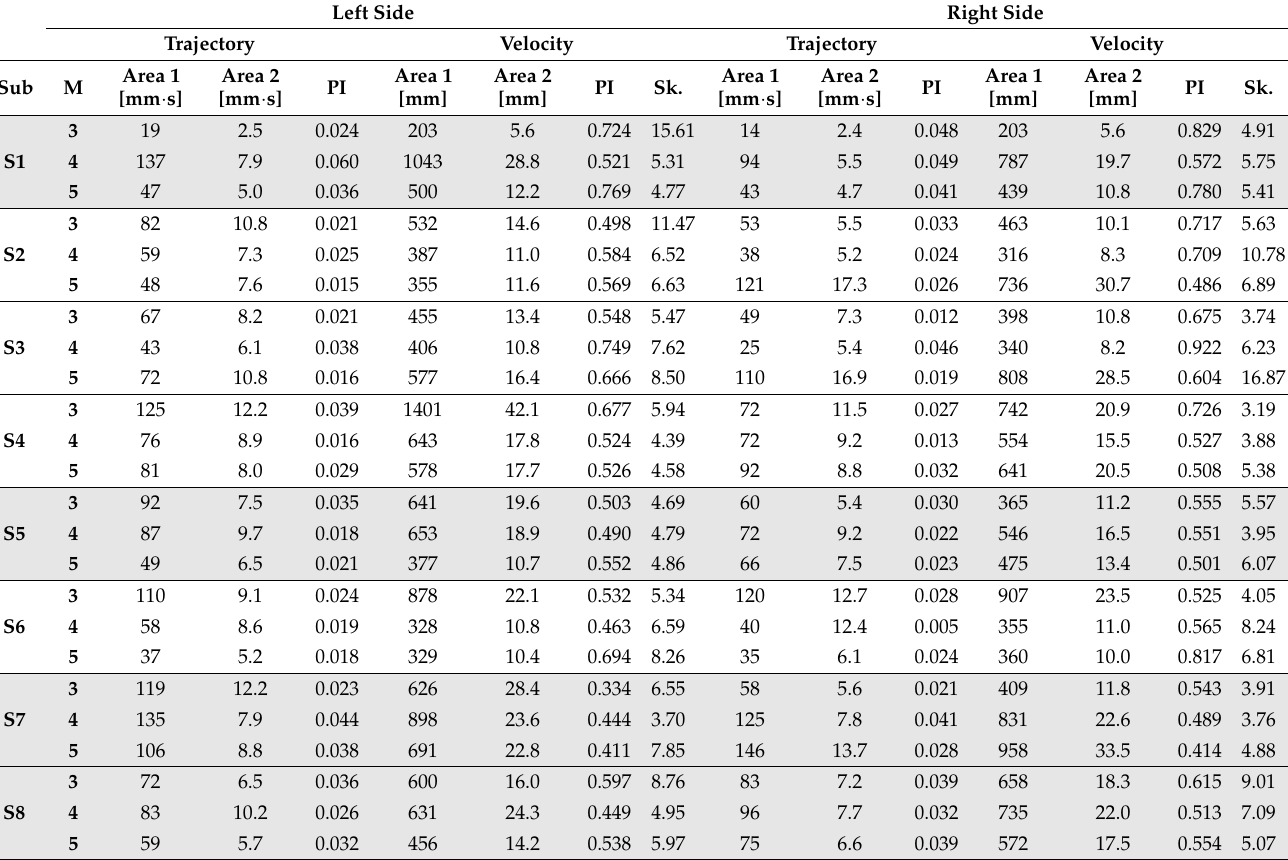
Table A1. Relevant values of parameters of “Left side” and “Right side” described in Figure 4 obtained from wrist trajectories and velocities for each infant at each timepoint (3, 4 and 5